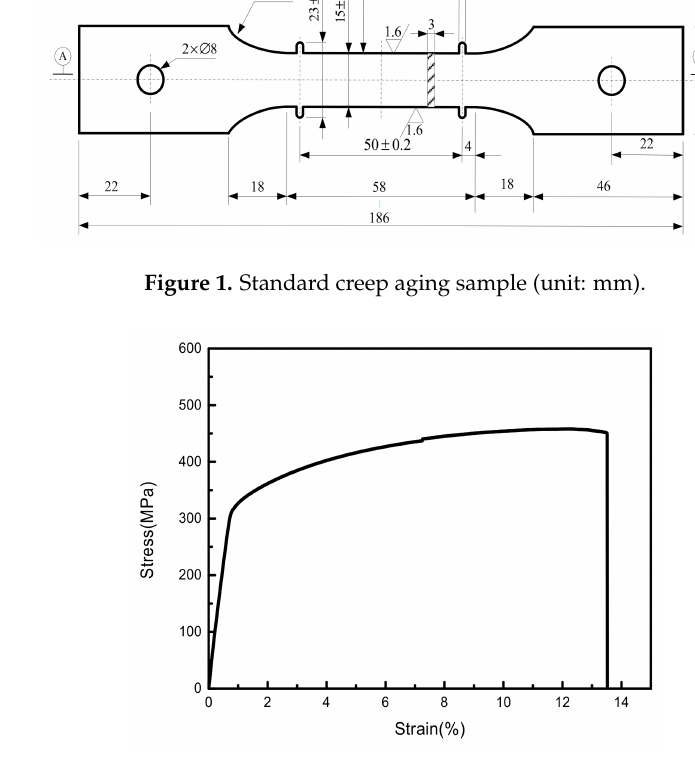
Figure 2. Stress-strain curve of the initial